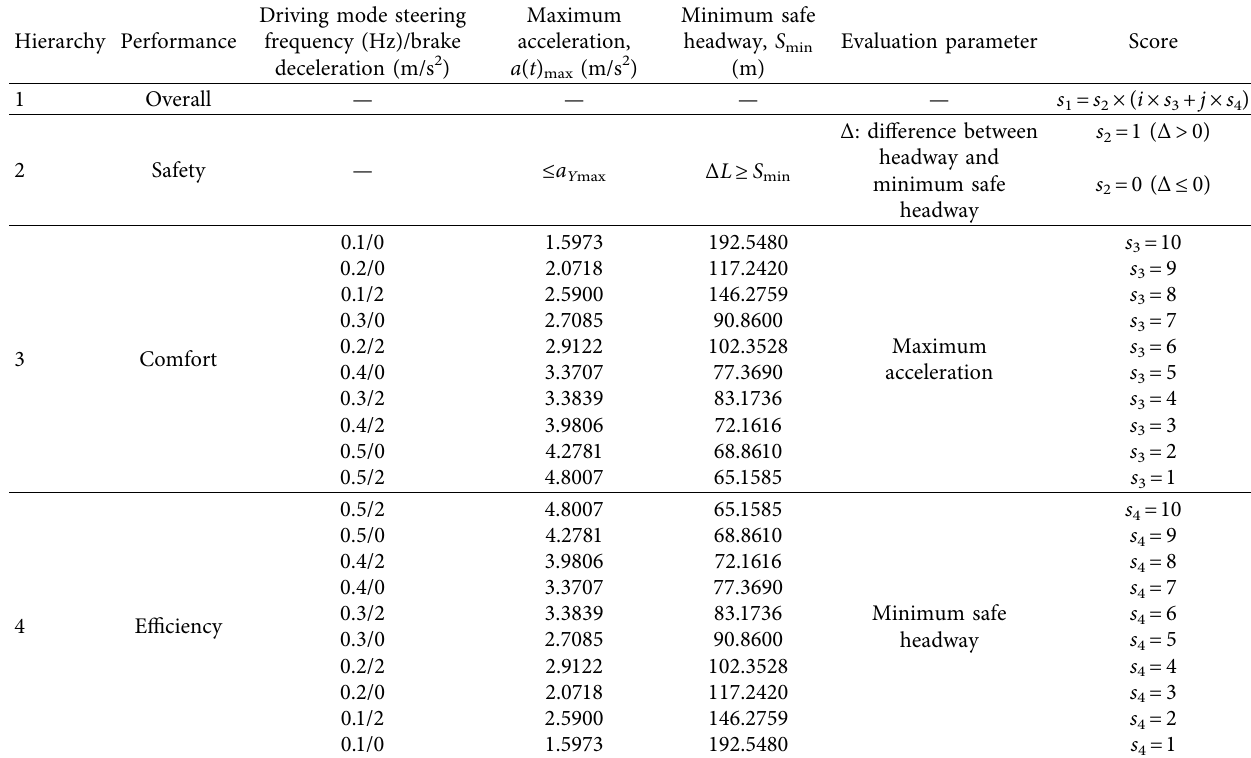
Table 3: Hierarchical scoring reference with relative velocity of